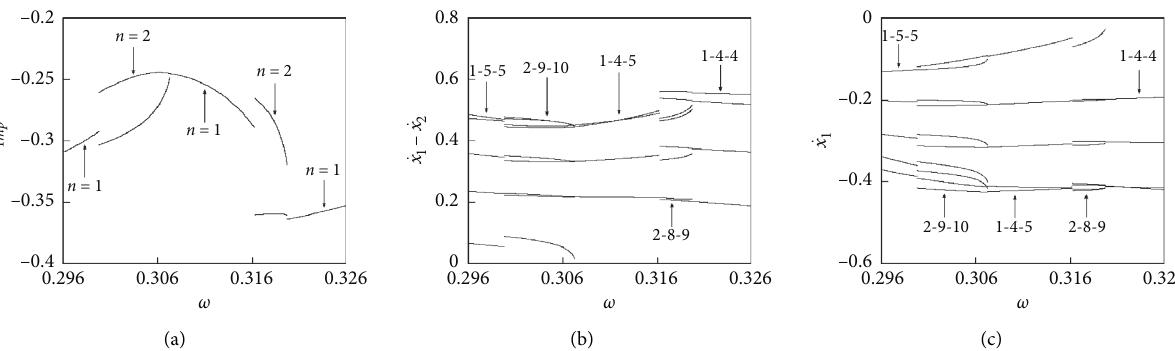
Figure 7: Bifurcation maps of nonhysteretic transition region of adjacent basic periodic impact vibrations 1-4-4 and 1-5-5, δ � 0.61. (a)